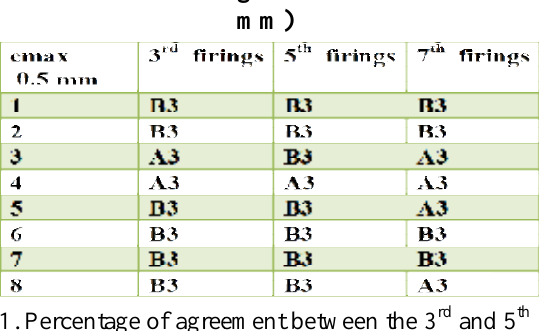
Table 4: Shade results of group B1 (e.max core with veneering ceramic thickness 0.5